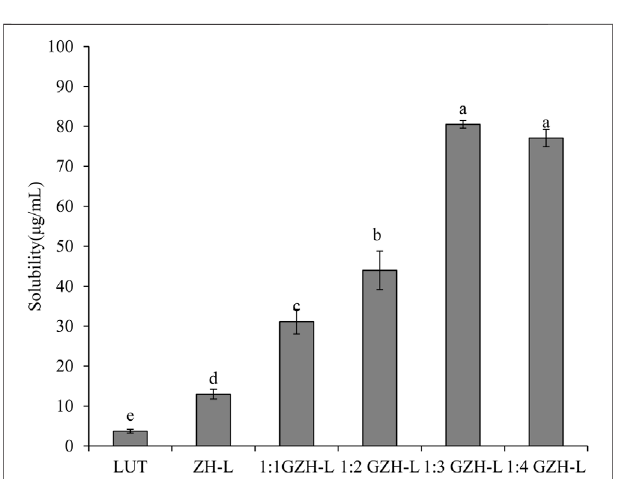
FIGURE 6 | Solubility of LUT, ZH-LUT and GZH-LUT nanoparticles.